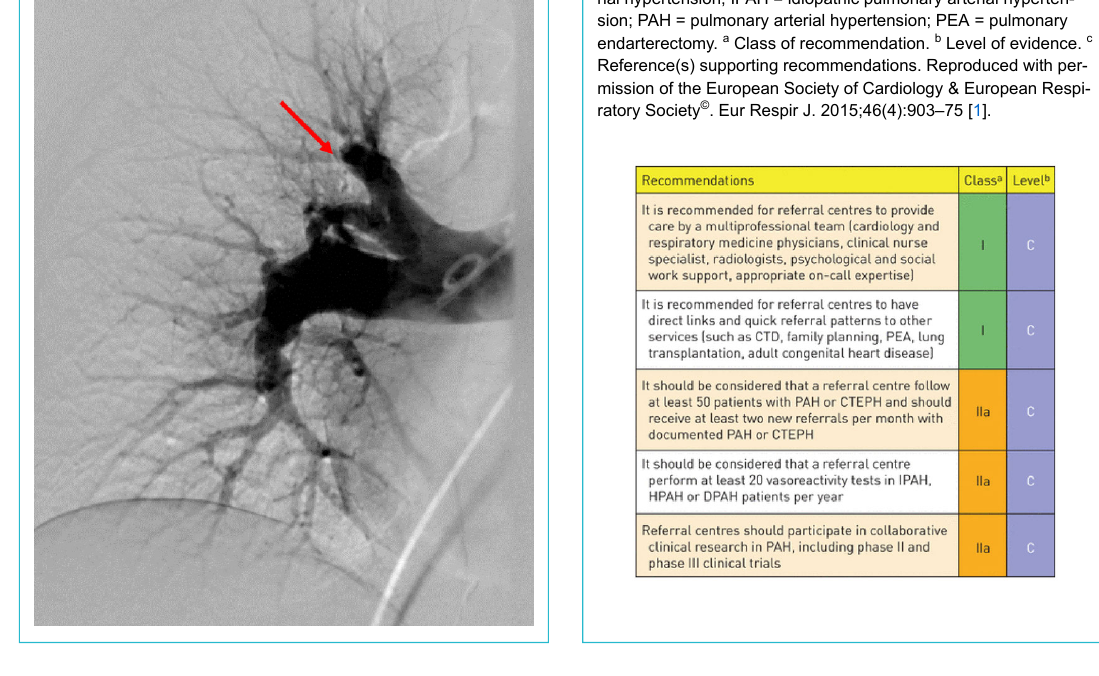
centres. CTD = connective tissue disease; CTEPH = chronic thromboembolic pulmonary hypertension; DPAH = drug-induced pulmonary arterial hypertension; HPAH = heritable pulmonary arte- rial hypertension; IPAH = idiopathic pulmonary arterial hyperten- sion; PAH = pulmonary arterial hypertension; PEA = pulmonary endarterectomy. a Class of recommendation. b Level of evidence. c Reference(s) supporting recommendations. Reproduced with per-